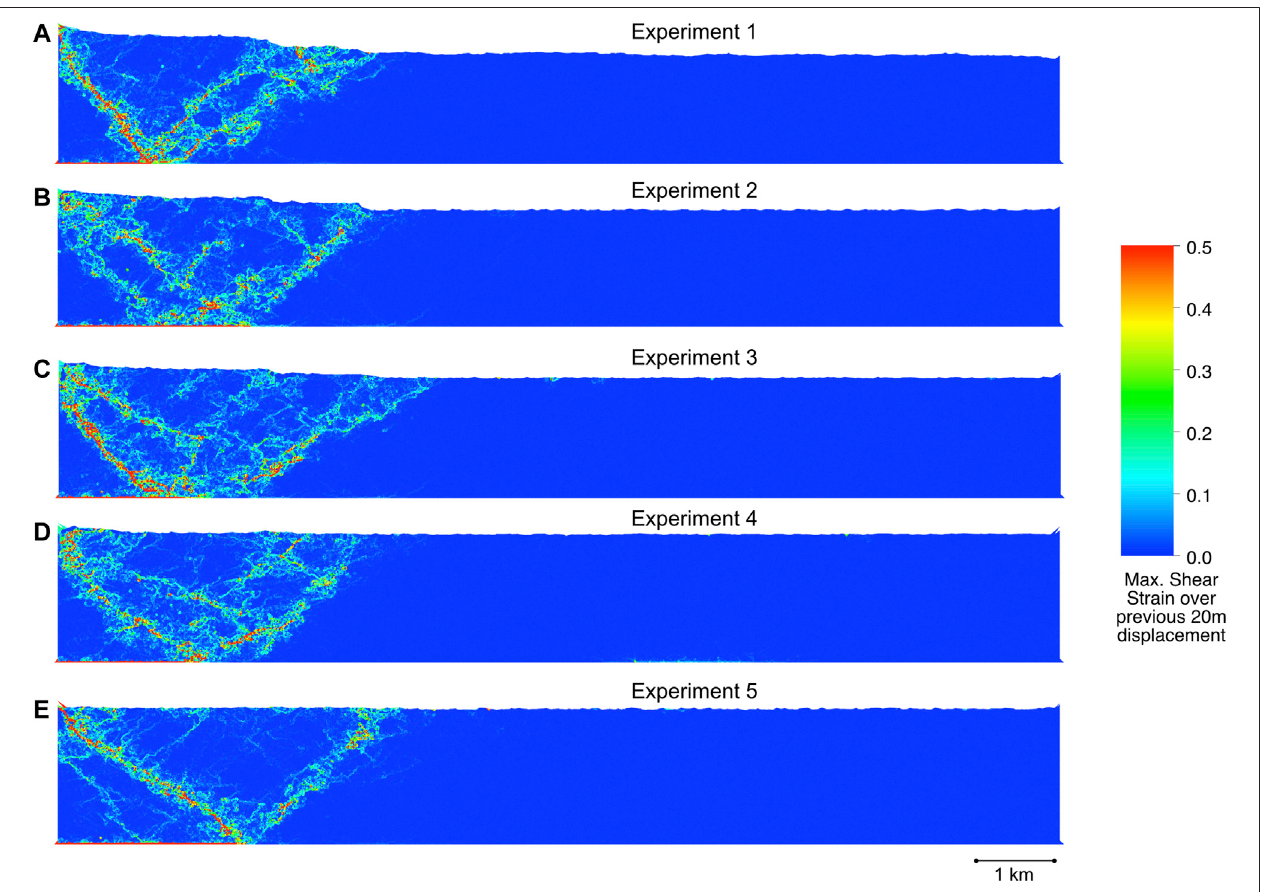
FIGURE 7 | Incremental maximum shear strain in all models over the previous 20 m of displacement at 4% shortening. Maximum shear strain colour scale is included to the right. See text for discussion.